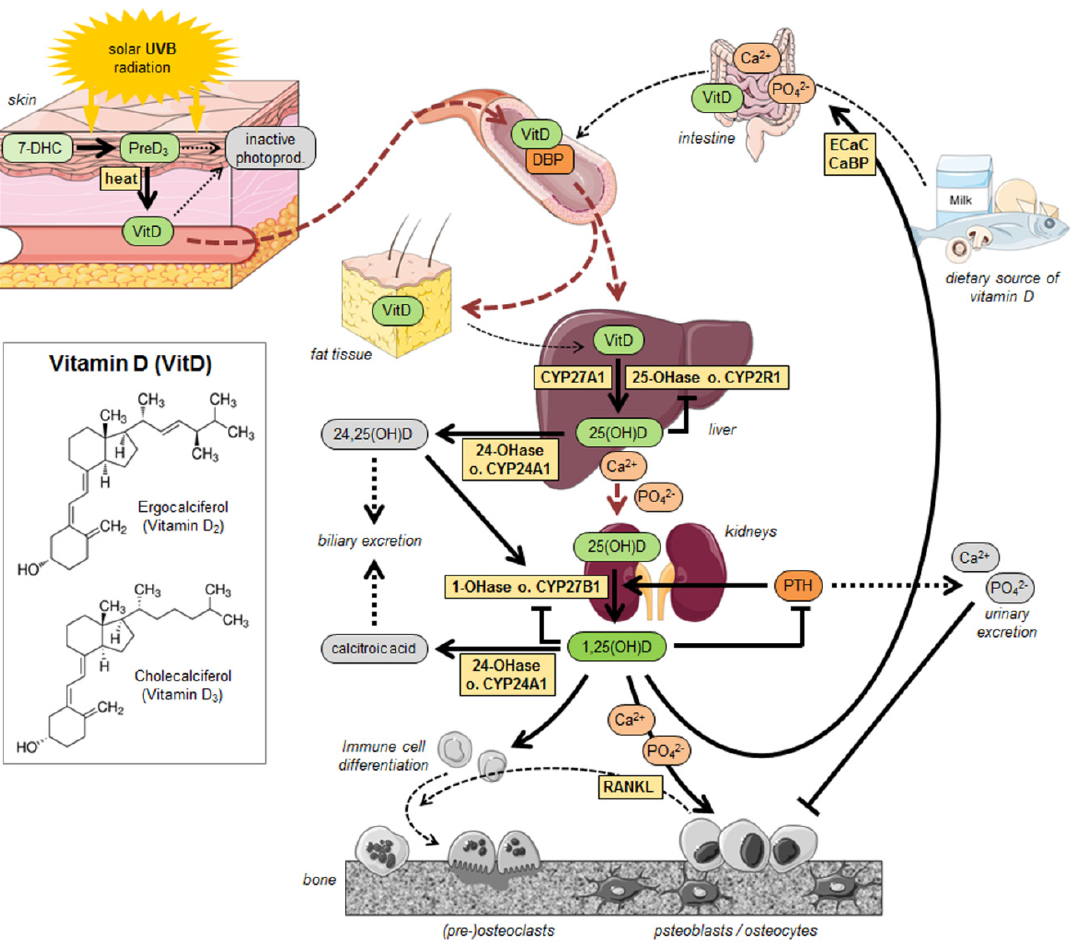
Figure 1. Schematic representation of admission and metabolism of vitamin D. Vitamin D is supplied by cutaneous synthesis or diet intake. The bloodstream takes it into the liver, where its chemical structure is changed by hydroxylation. Then it is sent to the kidneys for another hydroxylation. Finally, the active metabolite 1,25(OH)D circulates through the body in order to be effective. This graphic has been drawn up based on the schematic representation created by Shinchuk 2007 and Heath 2006 [6,7]. © 2016 Laboratoires Servier [22]